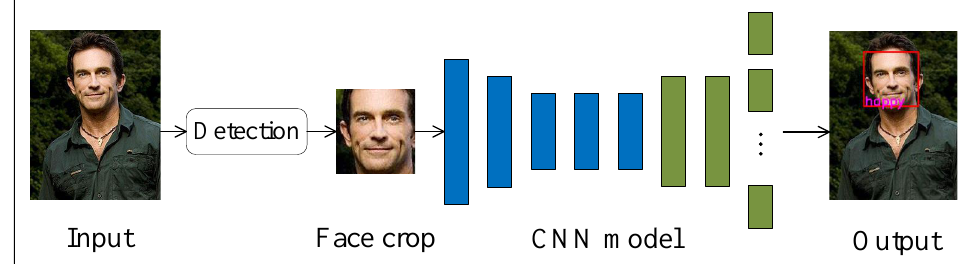
Figure 1. The workflow of the expression recognizer.